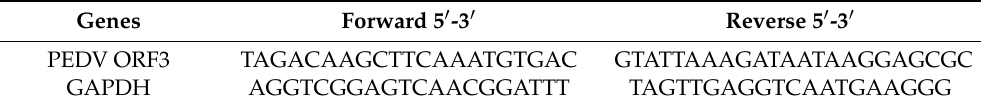
Table 1. Primers utilized in